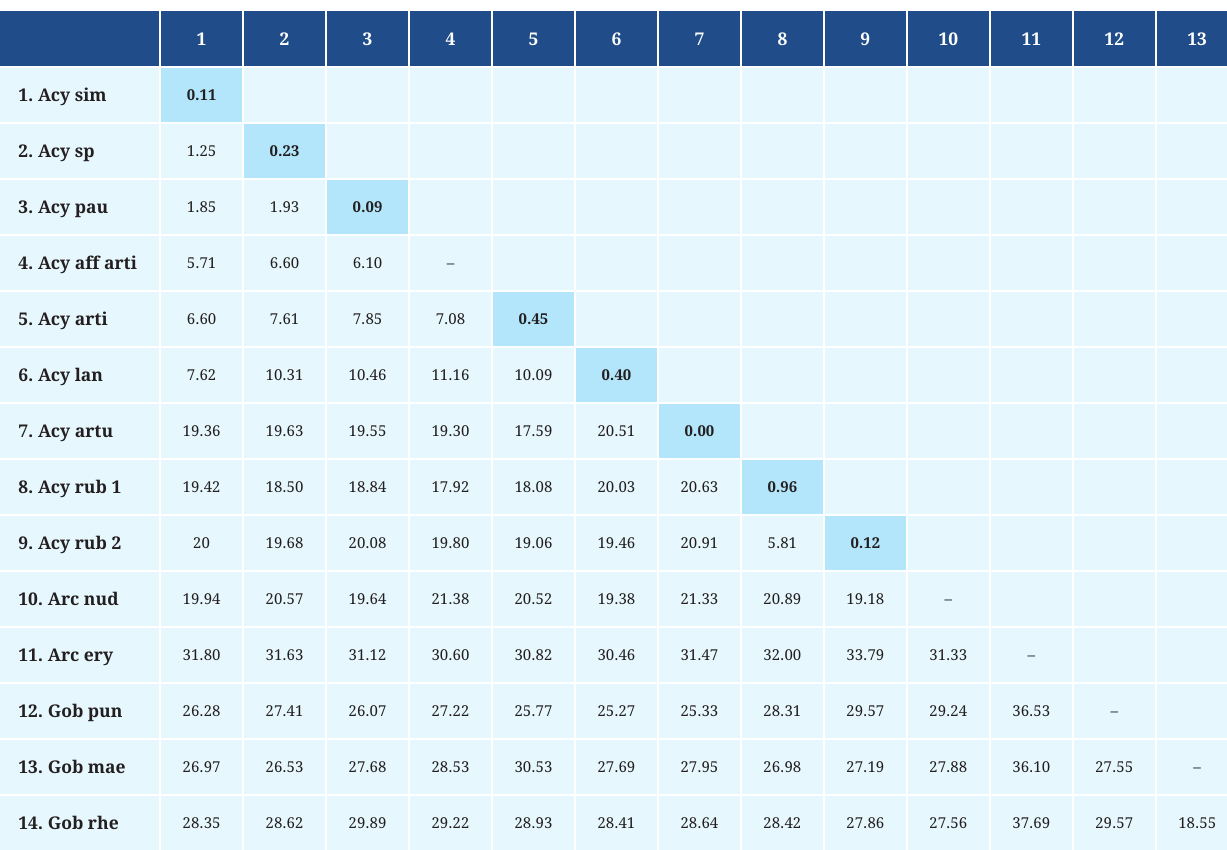
TABLE 3 | Interspecific and intraspecific (blue boxes) divergence among species of Acyrtus , Arcos , and Gobiesox (percentage values – %). Acy sim: Acyrtus simon ; Acy sp: Acyrtus sp; Acy pau: Acyrtus pauciradiatus ; Acy aff arti: Acyrtus aff. artius ; Acy arti: Acyrtus artius ; Acy lan: Acyrtus lanthanum ; Acy rub 1: Acyrtus rubiginosus lineage 1; Acy rub 2: Acyrtus rubiginosus lineage 2; Acy artu: Acyrtus arturo ; Arc nud: Arcos nudus ;